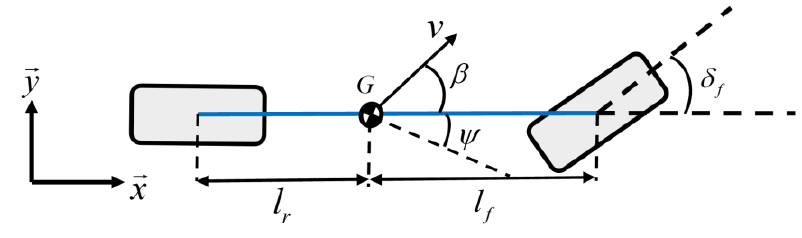
where are the horizontal and vertical coordinates of the left front wheel in the in- ertial coordinate system, respectively, of the right front wheel in the inertial coordinate system, respectively, and b is the front wheel track,  is the vehicle yaw angle, v is the vehicle speed, and tances between the vehicle center of gravity and the front or rear axles, respectively.